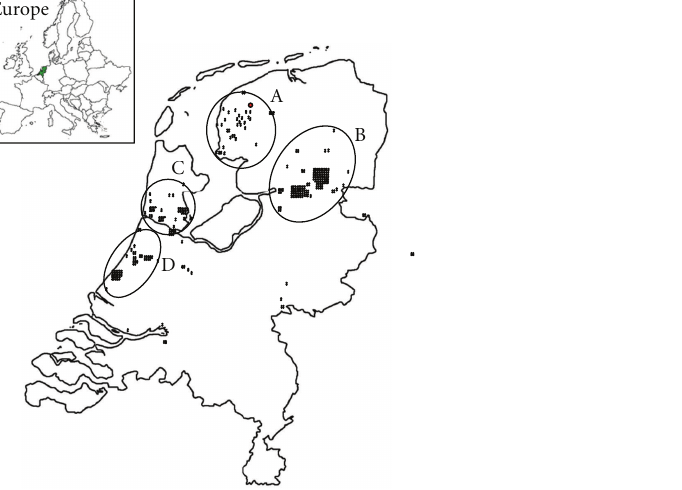
Figure 2: Domicile of the ancestors of patients. VU811 (area A), VU166, VU1131, and VU1134/35/36 (area B), VU239 (area C), and VU806 (area D). Ancestors of patients VU001 and VU002 lived in area B, C, and D. Ancestors of patient VU158 lived in areas C and